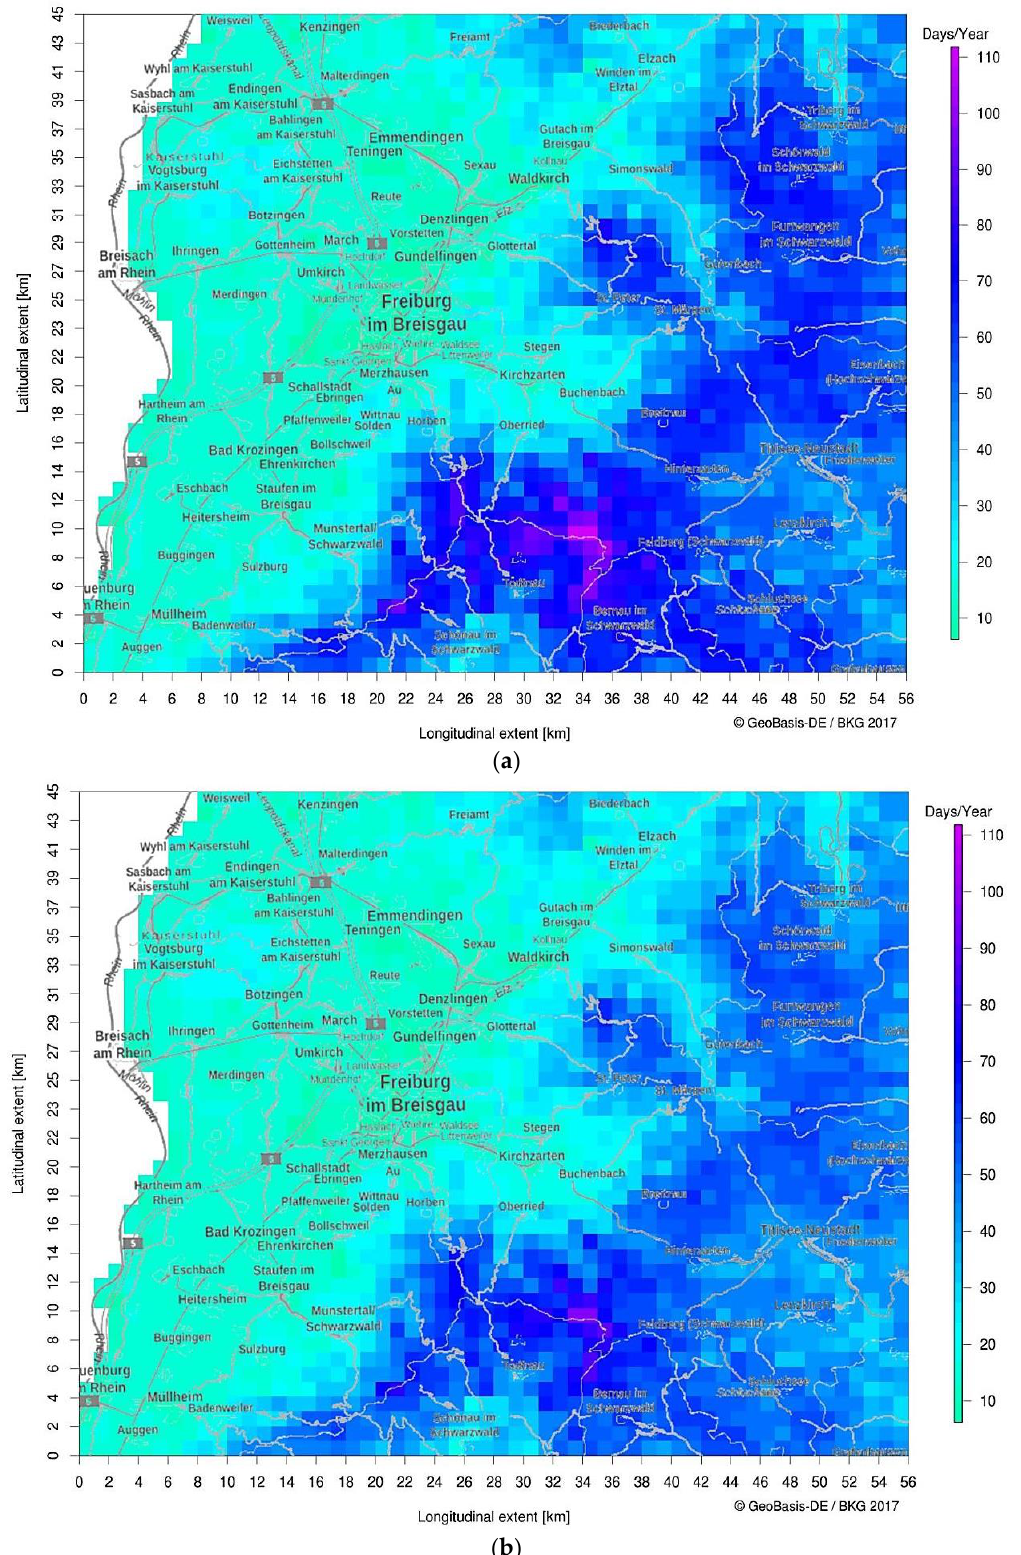
Figure 2. Spatial distribution of cold stimulus within the study area of southern Baden averaged over the time period 1995–2012: ( a ) cold stimulus days without consideration of acclimatisation effects (CS days) and ( b ) CS days with acclimatisation effects (CS ACC days).